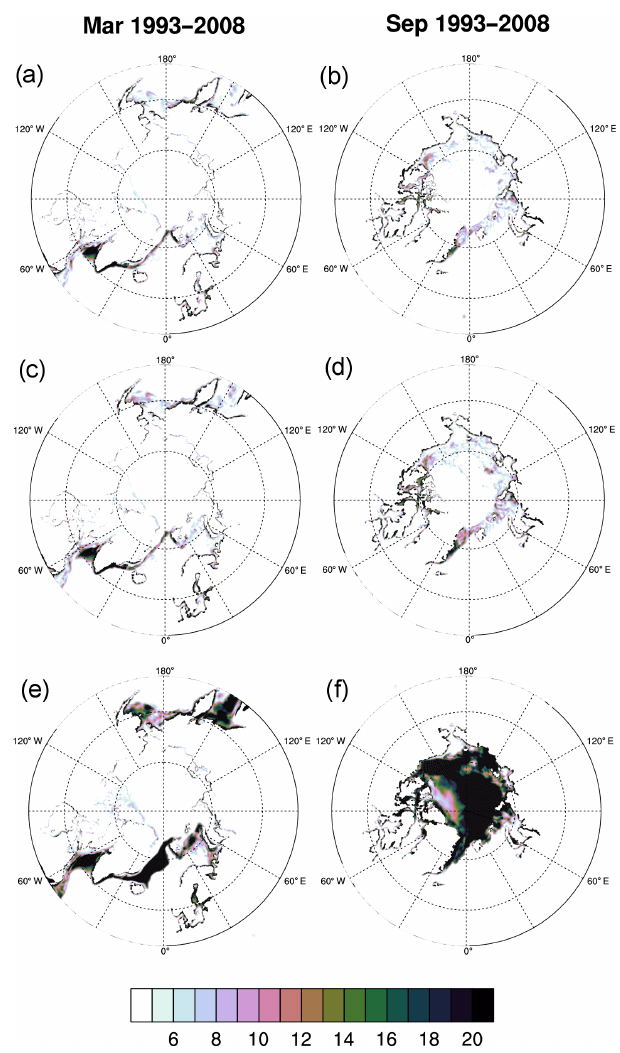
Figure 23. The RMSD (in percent) of ocean syntheses SIC with re- spect to SI_cci1.1 SIC data in (a, c, e) March and (b, d, f) Septem- ber; ocean synthesis SICs are from (a, b) ORAP5, (c, d) ORAS5 and (e, f) CTL-HadIS. Statistics are computed using monthly SIC data over the 1993–2008